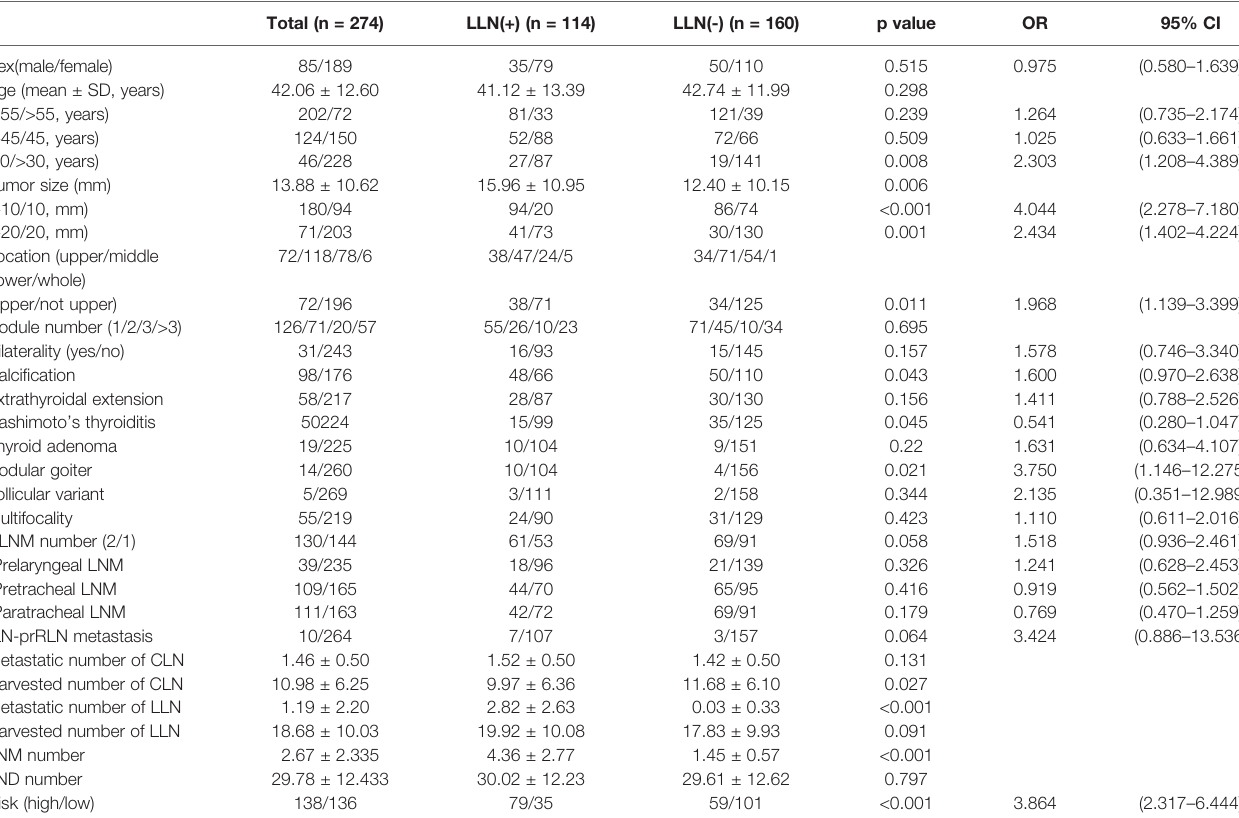
TABLE 2 | Univariate analysis of one to two CLNM patients with and without